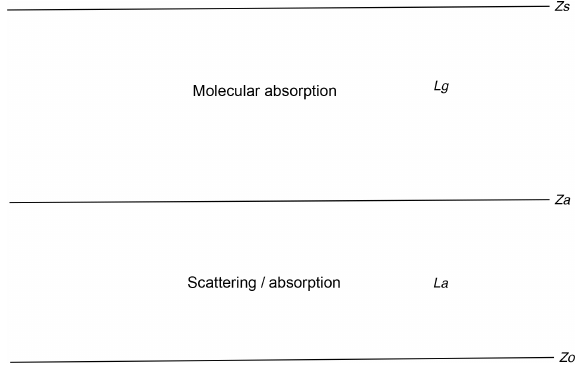
Figure 4. Atmospheric vertical structure of the FASTRE model. The surface is at level Z 0 and radiatively coupled with the lower layer L a extending from level Z 0 to Z a . This layer includes scatter- ing and absorption processes. The upper layer, L g , runs from level Z a to Z s and only accounts for gas absorption